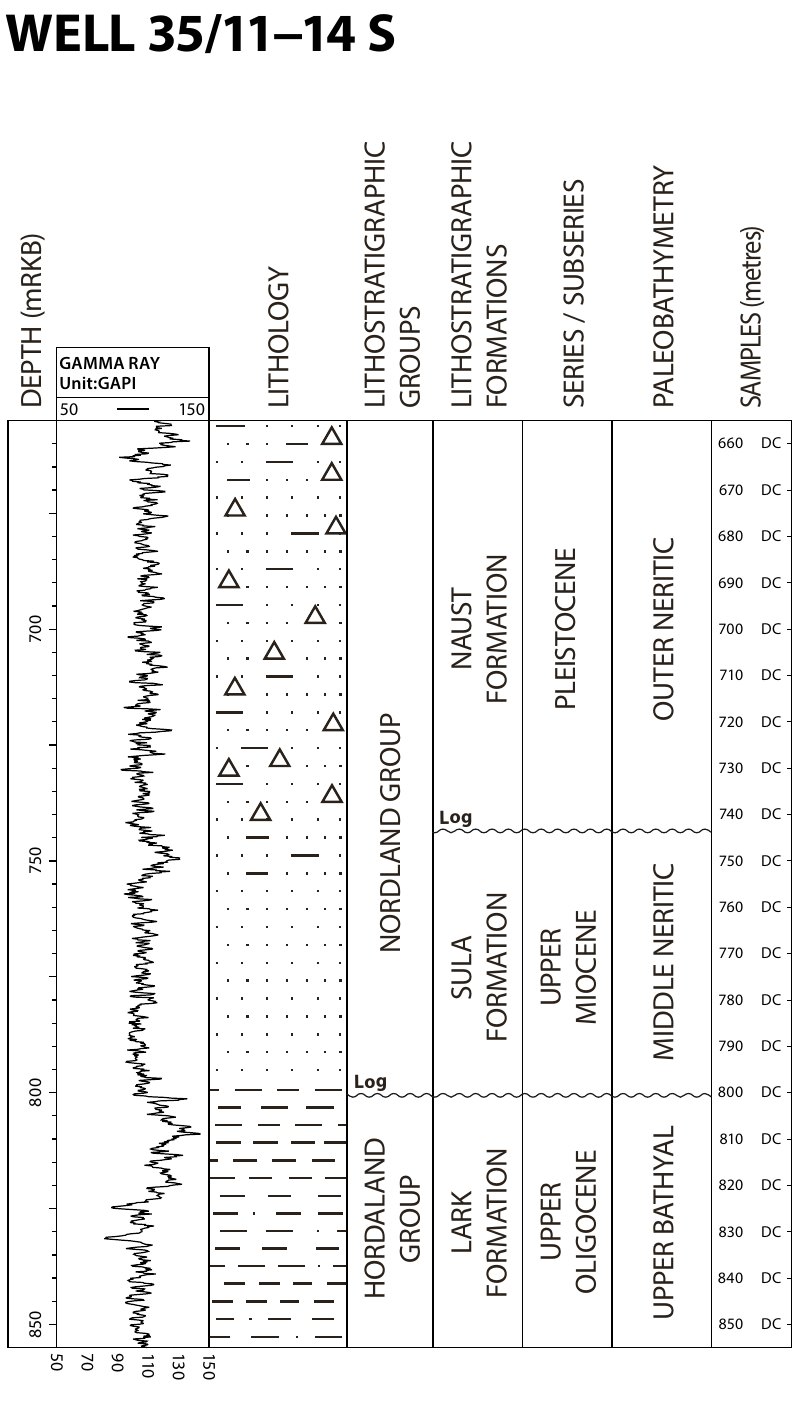
Figure 63. Well summary figure for the upper Oligocene to Pleistocene in well 35/11–14 S including gamma-ray log, lithology, lithostratigraphic units, series/subseries, paleobathymetry and analysed samples, including the reference section for the Sula Formation (modified after Eidvin et al.,